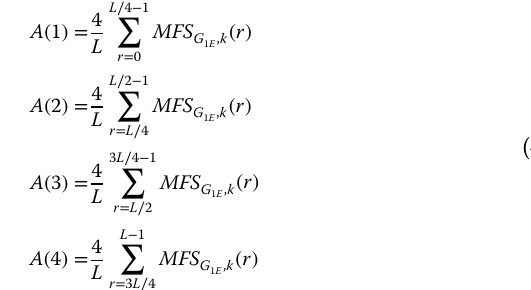
Fig. 18 Some exemplar random walk patterns leading to the central pixel. Walk length is d auto-population) was